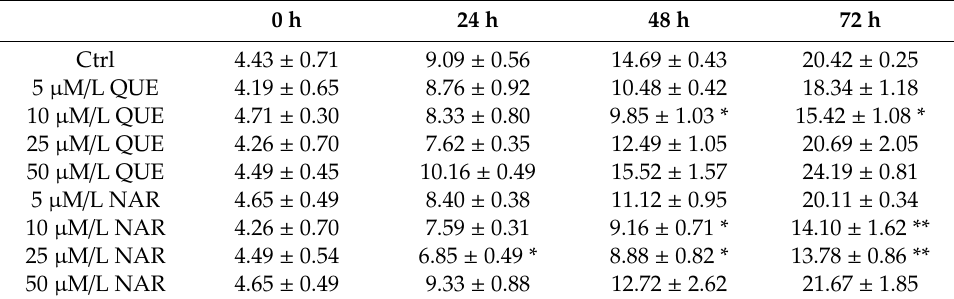
Table 7. The e ff ect of quercetin and naringenin on the amount of malondialdehyde ( µ mol / g protein) in extended boar spermatozoa ( n =